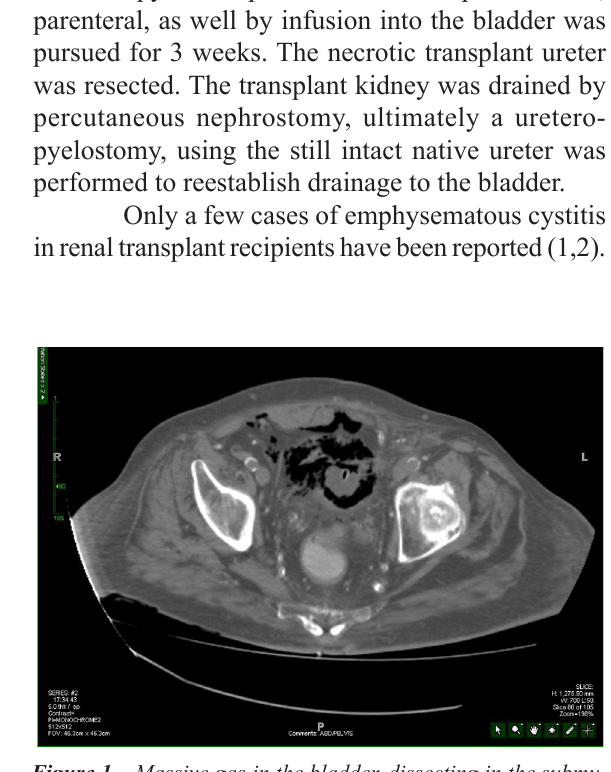
Figure 1 – Massive gas in the bladder, dissecting in the submu- cosal layer and extending into the space of